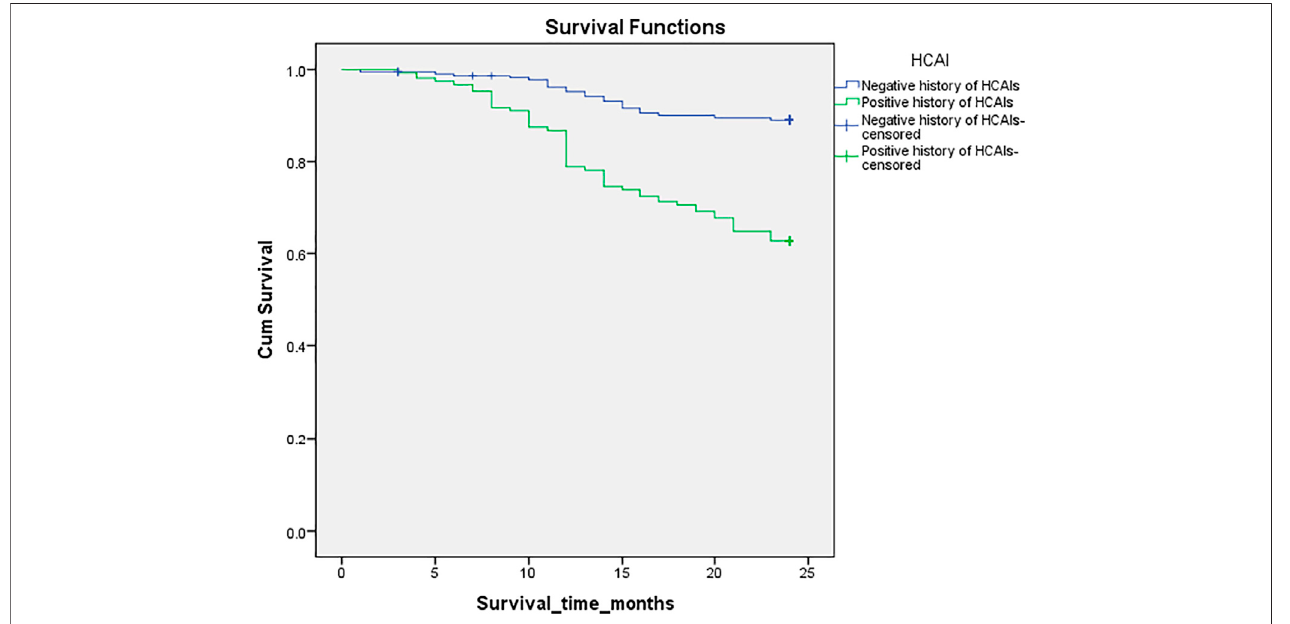
FIGURE 1 | Kaplan-Meier survival analysis in patients with and without healthcare associated infections. Cum survival; Cummulative survival.